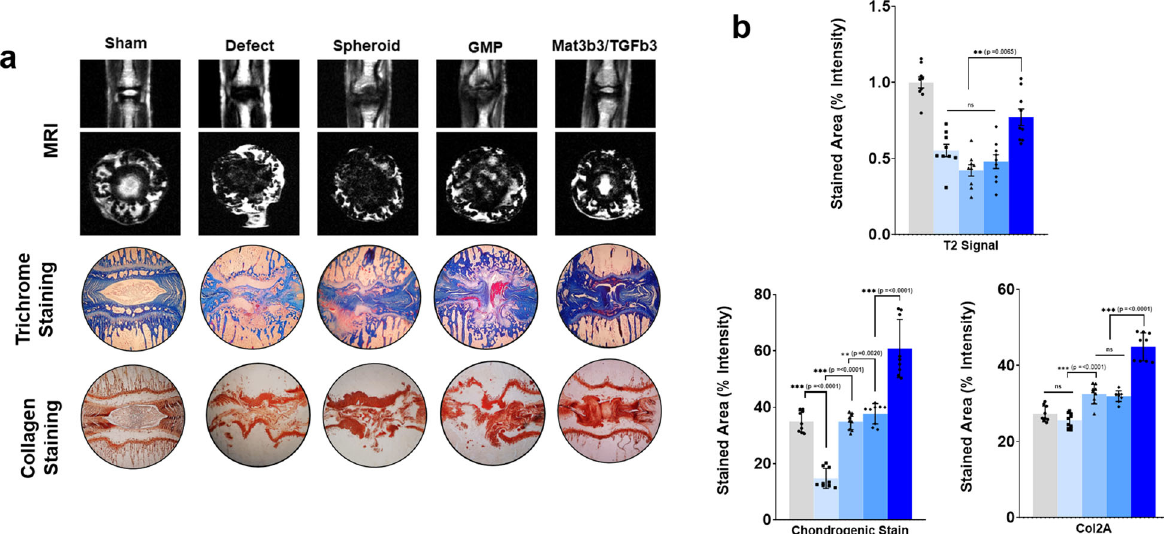
Fig. 10 Radiographic and gross histological staining of rat intervertebral disks. Lateral MRI scans of IVD segments indicating the presence of cartilaginous tissue between adjacent rat-tail vertebrae ( a , top panel). Representative images of the trichrome staining on 10-µm IVD sections ( a , middle panel). Representative images of collagen type-2 immunostaining on 10-µm IVD tissue sections ( a , bottom panel). The images are representative sections from nine independent IVD sites from three mice (3 IVD sites/mice). Quantitative digital analyses of the MRI scans, trichome staining, and Collagen type-2 immunostaining ( b ). Error bars denote the means ± standard error of mean (sem) (ns = not signi fi cant, * p < 0.05, ** p < 0.01, *** p < 0.001; **** p < 0.0001). Individual data points and p -values for signi fi cance are indicated in the